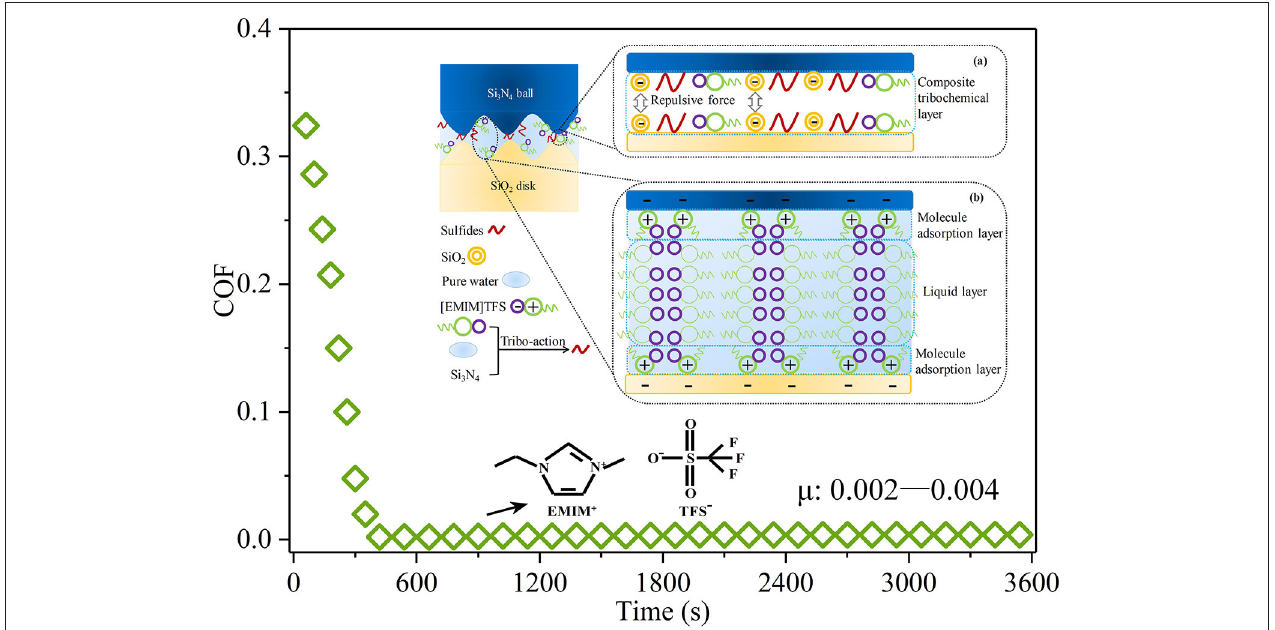
FIGURE 9 | COF of the [EMIM]TFS aqueous solution. The inset shows the proposed superlubricity model. Ge et al. (2018b) Copyright 2018, American Chemical Society.